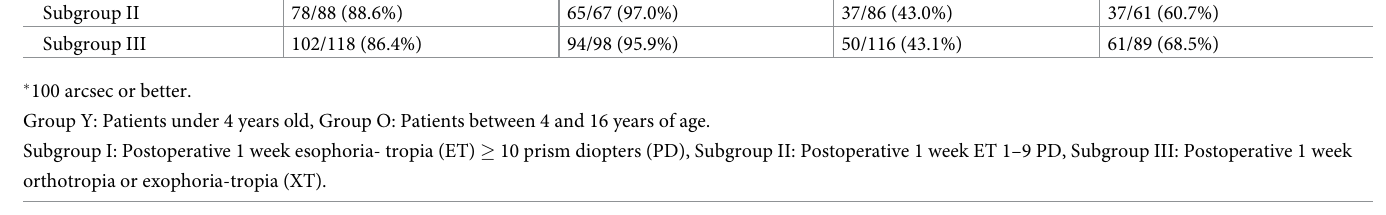
Seven (5.38%) and 18 patients (6.90%) patients in groups Y and O, respectively, underwent reoperation for recurrent exotropia within 2 years from the first operation. All patients in group Y who underwent reoperation were included in subgroup III. In group O, there were 4, 4, and 10 patients who underwent reoperation in subgroups I, II, III, respectively. Consecutive esotropia occurred in 9 (6.9%) patients in group Y (8, 1, and 0 patients in sub- groups I, II, and III, respectively) and in 7 (2.6%) patients in group O (5, 2, and 0 patients in subgroups I, II, and III, respectively) at 1 month postoperatively; the difference between groups Y and O was not statistically significant (p = 0.695). However, it only persisted in 2 patients in group Y (2 in I) and 1 in group O until the last visit. Due to poor cooperation and visual immaturity, the preoperative sensory status (as measured by the Titmus and Worth- 4-dot tests) was not obtained in most consecutive esotropia patients in group Y. Therefore, comparing the postoperative deterioration of sensory status in consecutive esotropia between groups Y and O was not possible. However, of the patients with consecutive esotropia (9 and 7 in groups Y and O, respectively), 66.7% (4/6) in group Y reported 100 arcsec or better in the Titmus Stereotest and 50% (3/6) reported fusion on the Worth-4-dot test, while these values were reported in 85.7% (6/7) and 57.1% (4/7) of patients in group O, respectively, which indi- cated comparable results between the 2 groups.